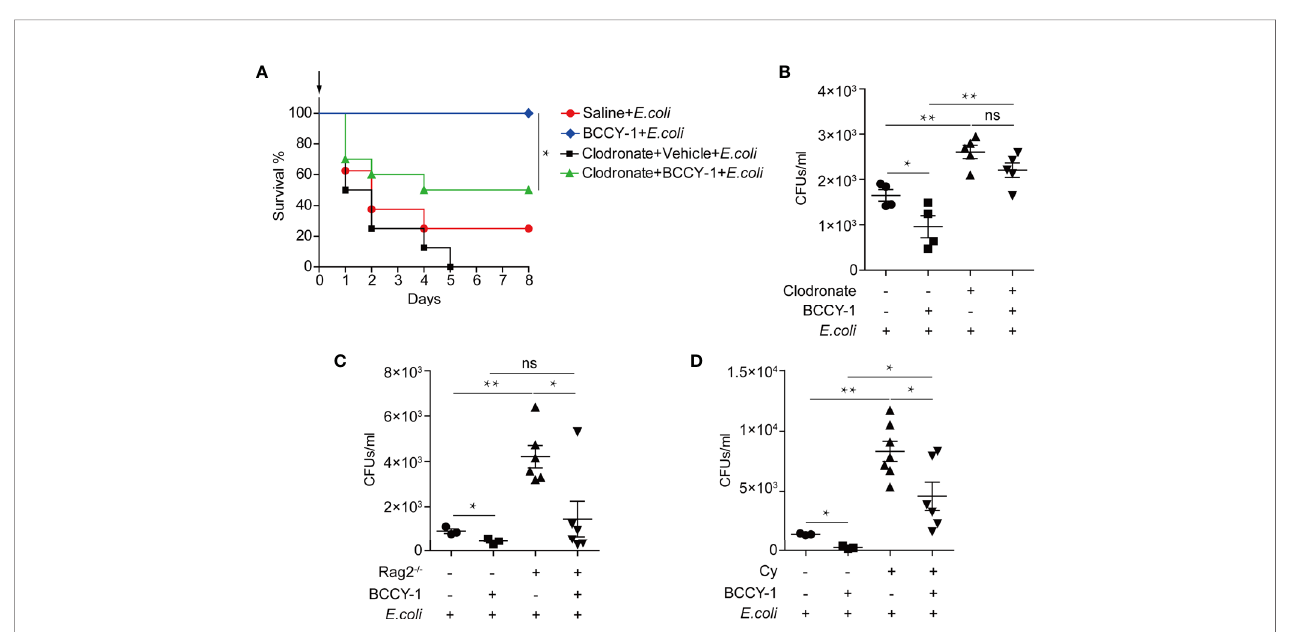
FIGURE 5 | Effects of BCCY-1 in speci fi c cell-depletion mouse models. To deplete monocytes/macrophages, C57BL6/J mice were treated once with clodronate liposomes. Two days after liposome treatment, BCCY-1 (10 mg/kg/day, for 2 days) or saline was administered by i.p. injection. After 48 h administration, mice were infected with E.coli via i.p. injection. (A) The day of challenge was designated as day 0 (black arrow). Survival of mice (n=8-10) was measured and (B) bacterial CFU counts were determined in the peritoneal lavage at 24 h after infection. n=4-5, ns p >0.05, * p <0.05, ** p <0.01. (C) The bacterial CFU counts were determined in the peritoneal lavage fl uid of the lymphopenia models at 24 h after infection. n=3-6, ns p >0.05, * p <0.05, ** p <0.01. (D) The bacterial CFU counts were determined in the peritoneal lavage of the neutropenic models at 24 h after infection. n=3-7, Cy: Cyclophosphamide, * p <0.05, ** p <0.01.